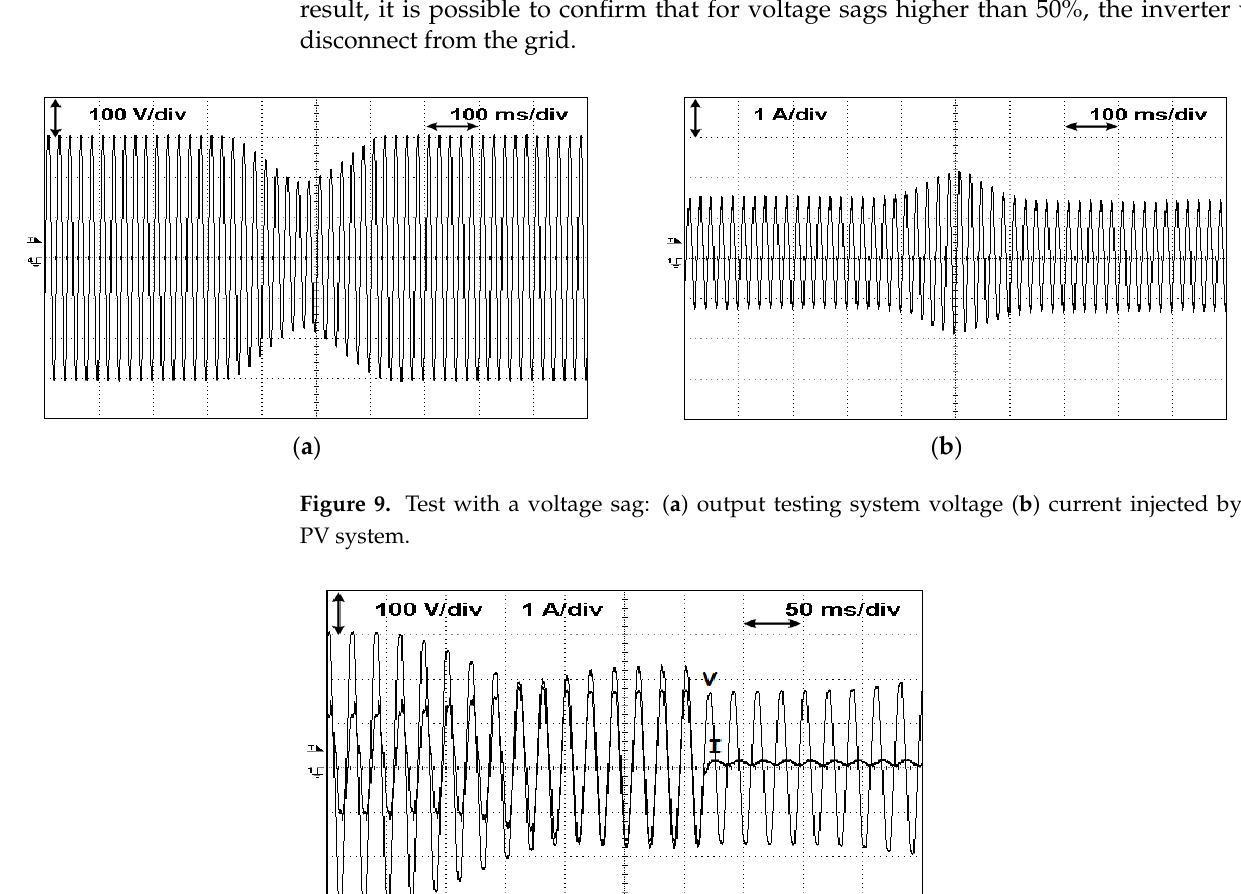
Figure 10. Test with a continuous reduction in the output testing system voltage until the PV inverter disconnects.